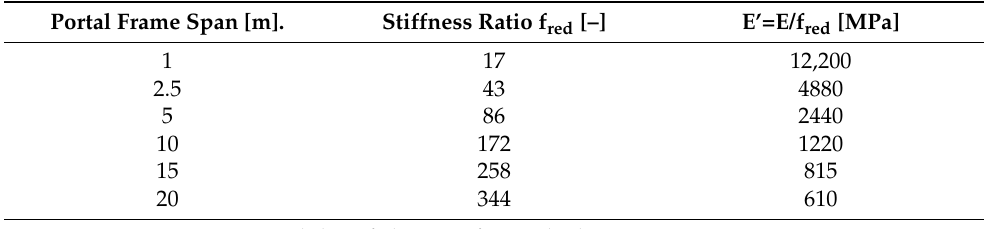
Table 3. Comparison of the stiffness values of tie elements used in experimental program and the one used in practice. Portal Frame Span